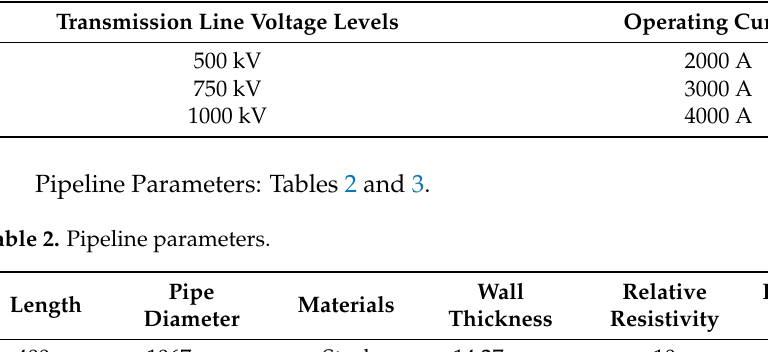
Table 1. Operating currents of different levels of transmission lines.